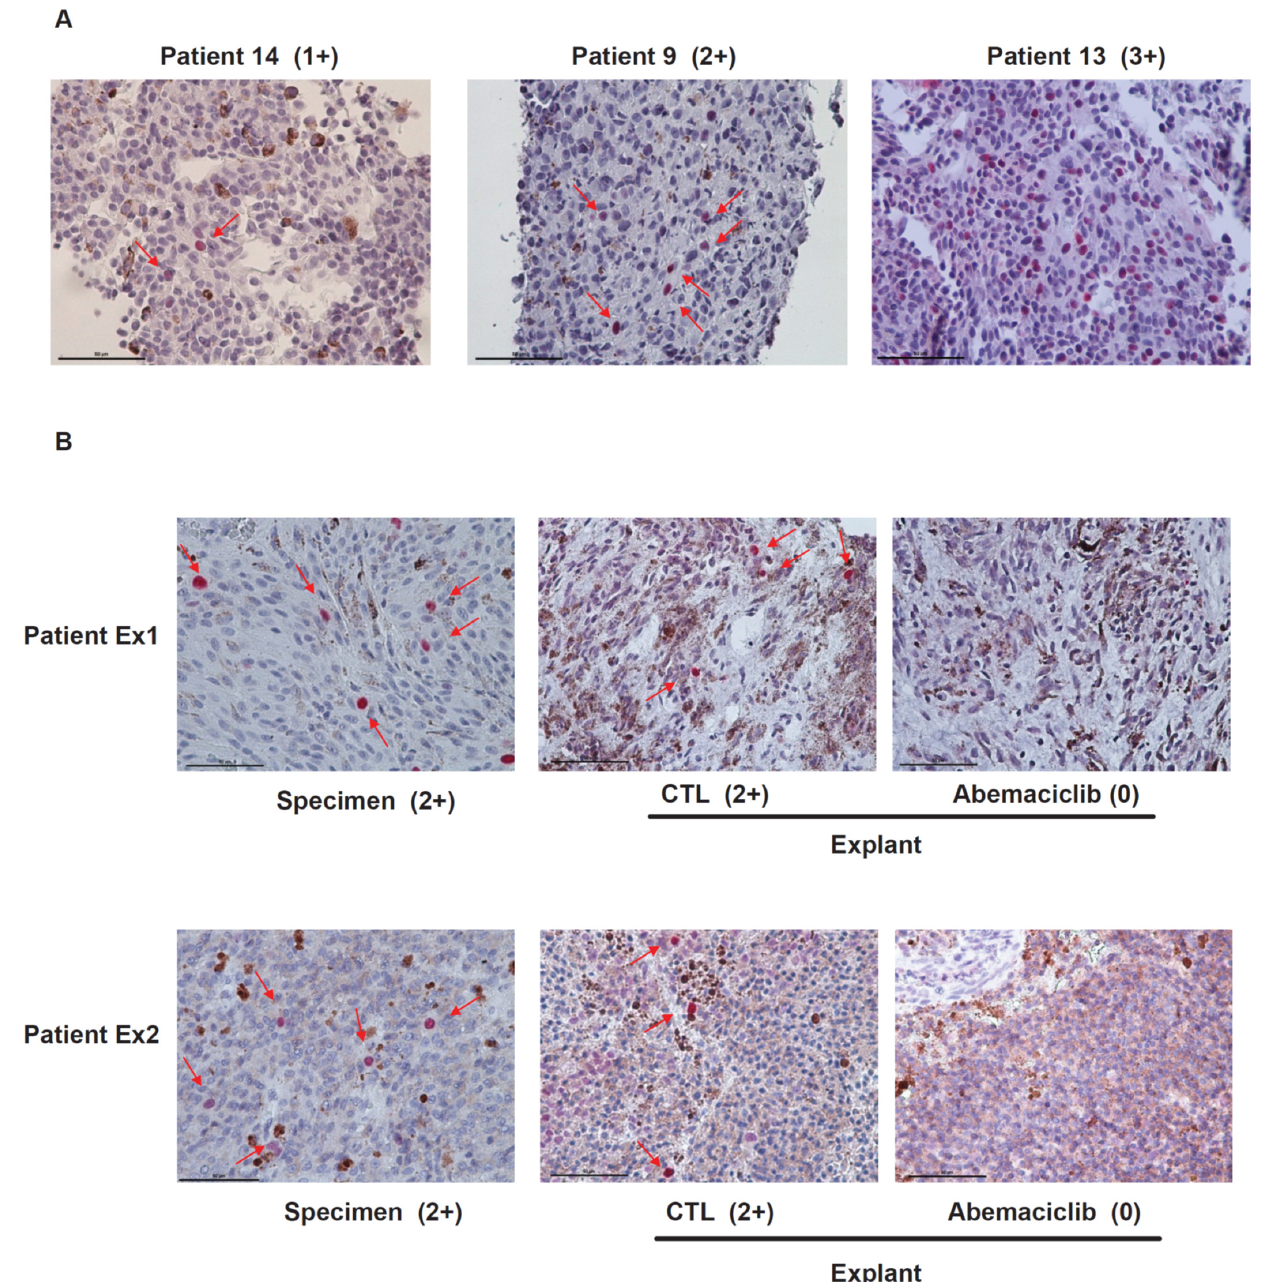
Figure 2. The phosphorylation of RB in metastatic uveal melanoma and the effect of abemaciclib on inhibiting phosphorylated RB in metastatic uveal melanoma (UM) explants. ( A ) Representative images (magnification, ×400) of phospho-RB staining (red color arrow) illustrating the progressively increasing staining scores for metastatic samples of uveal melanoma patients. Staining positivity was scored as 0, negative; 1+, positive staining in <1% of tumor cells; 2+, in 1% to 10% of tumor cells; 3+, in >10% of tumor cells. ( B ) Fresh UM tumors obtained from surgery were cut into approximately 1 mm 3 pieces and plated on Vetspon absorbable hemostatic gelatin sponges for 48 h. The sponges were pre-soaked in medium